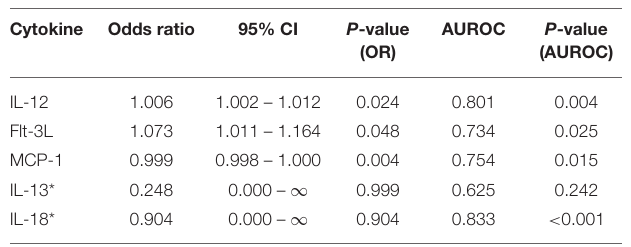
TABLE 4 | Odds ratios for the differentiation of cats with sepsis from those with septic shock based on measured cytokine concentrations. Cytokine Odds